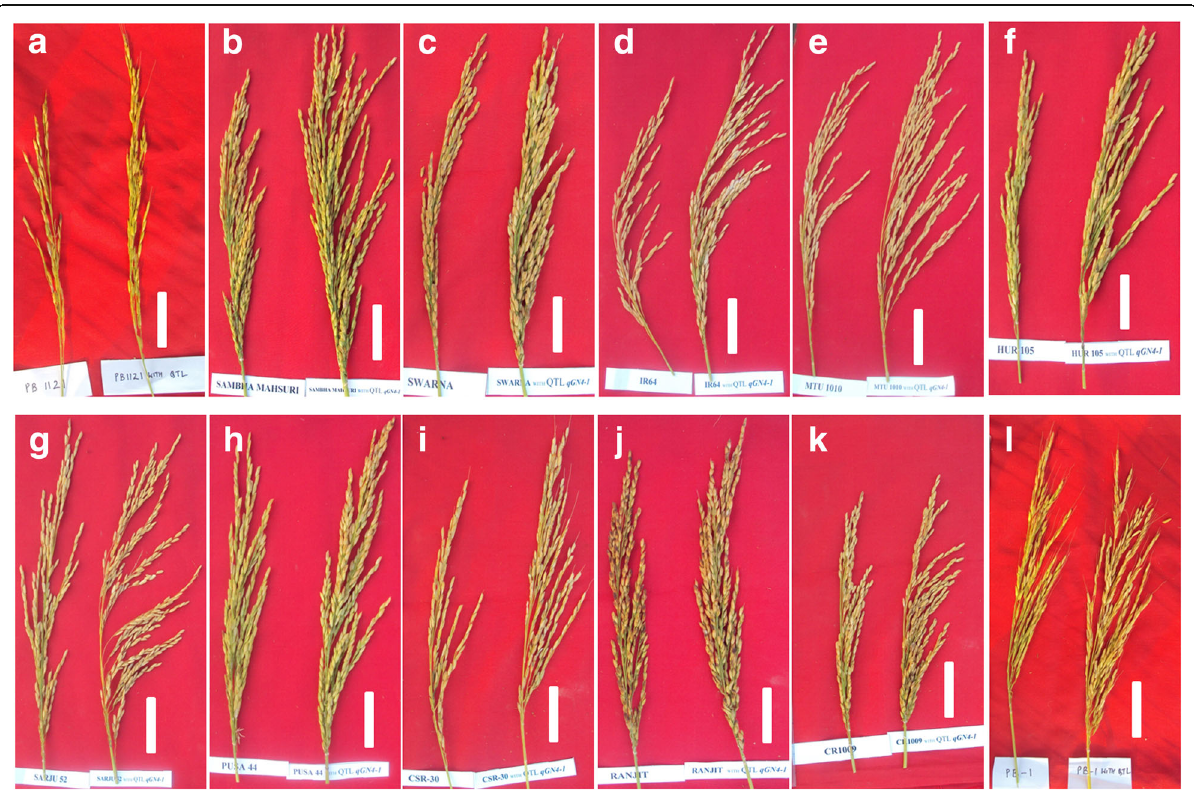
Fig. 4 Panicle structure of qGN4.1 QTL-NILs (right side) along with respective recipient parents (left side): a Pusa Basmati 1121 (PB 1121) b